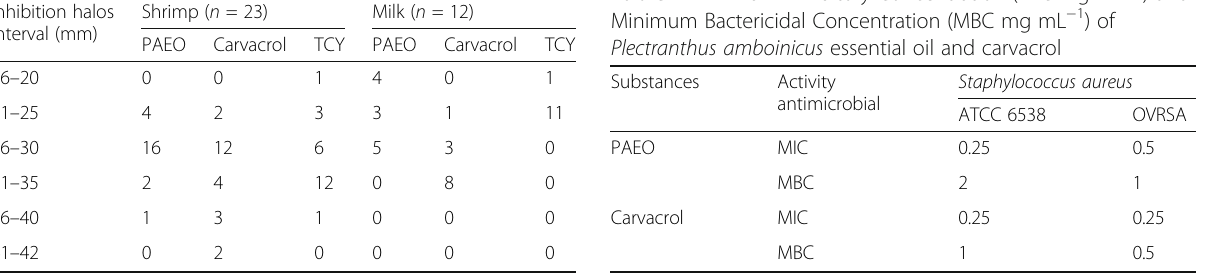
Table 4 Minimum Inhibitory Concentration (MIC mg mL − 1 ) and Minimum Bactericidal Concentration (MBC mg mL − 1 ) of